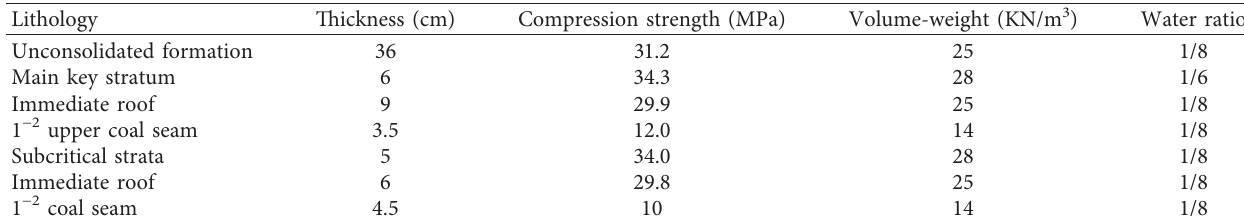
Table 4: Parameters of the indoor physical